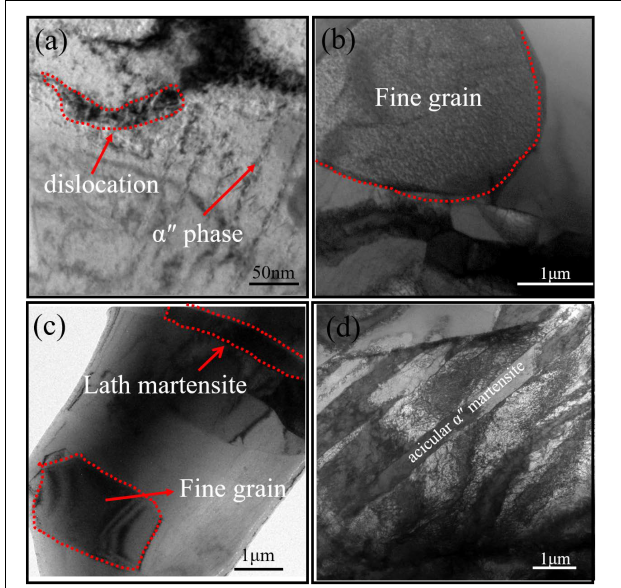
FIGURE 4 | Transmission electron microscopy images of Ti-35Nb-2Ta-3Zr annealed specimens: 723 K (a) ; 823 K (b) ; 923 K (c) , and 1023 K (d)